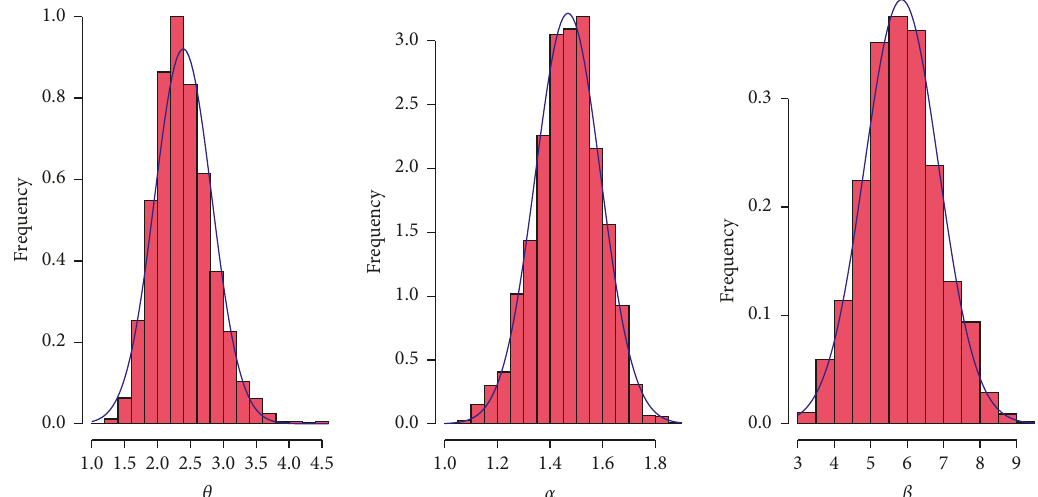
Figure 5: Density of posterior marginal of MCMC results of parameters for MKKu distribution for COVID-19 data of Saudi